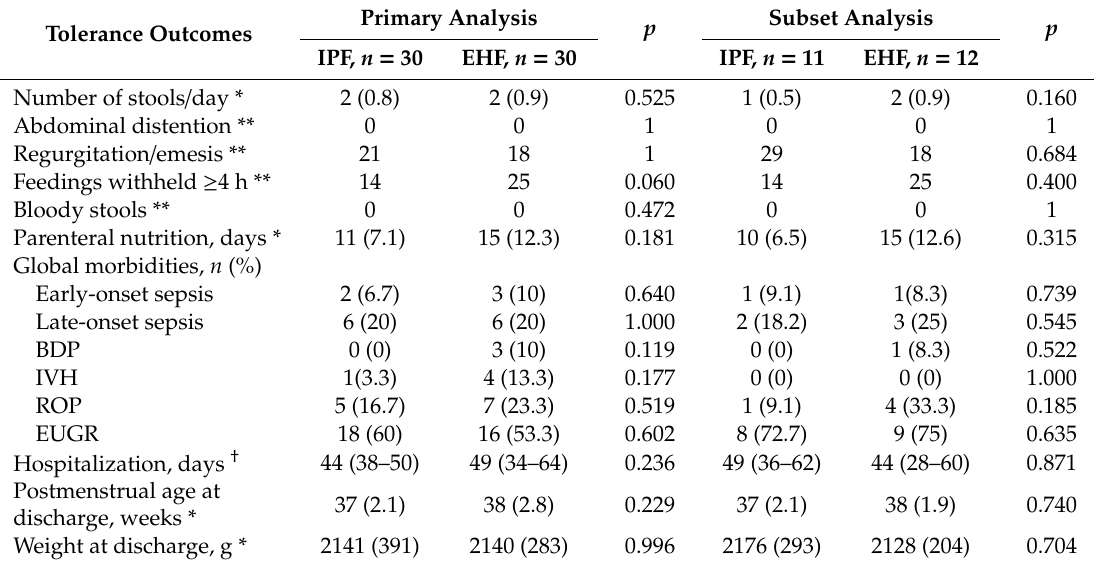
Table 3. Tolerance measures, respiratory status, and global morbidity during the study period and demographics at hospital discharge by primary (all participants who completed the study per protocol) and subset analysis (participants who received ≥ 75% enteral intake from study